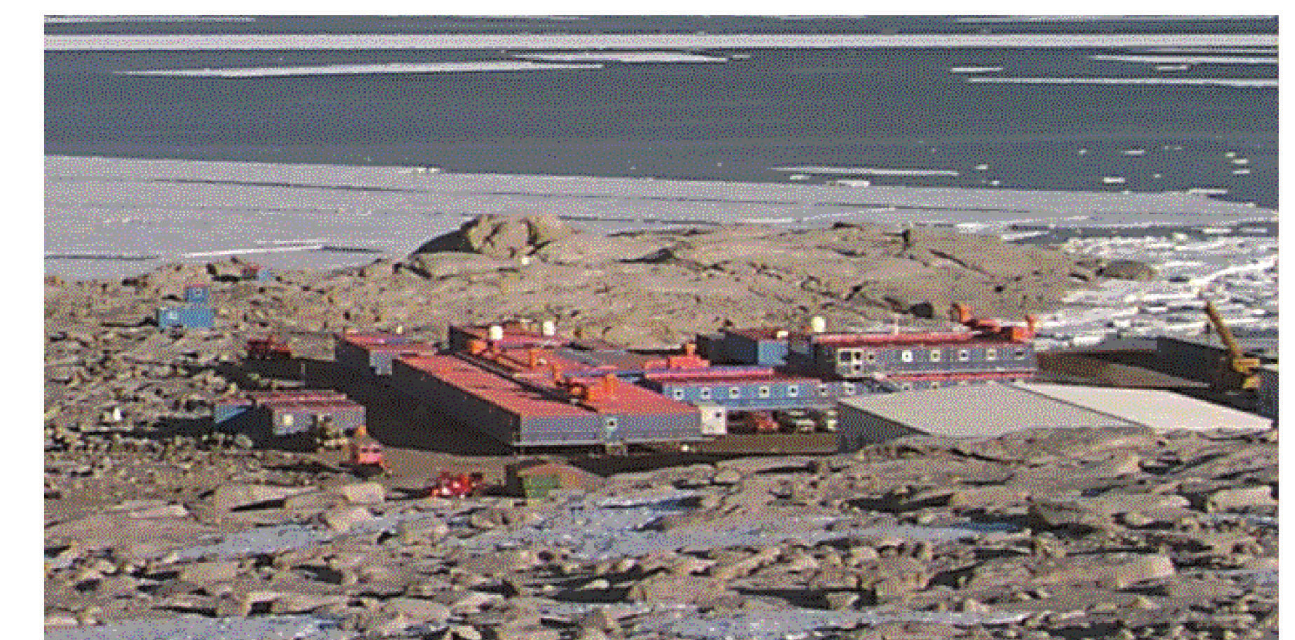
Fig. 1. A view of the Italian Base at Terra Nova Bay.